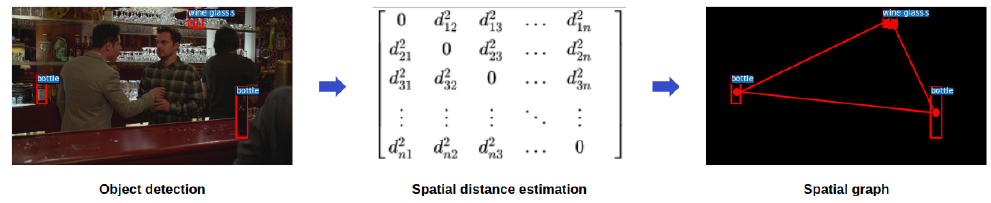
Figure 9. Spatial location graph generated for a frame using the centre of the bounding box co- ordinates and Euclidean distance between them.